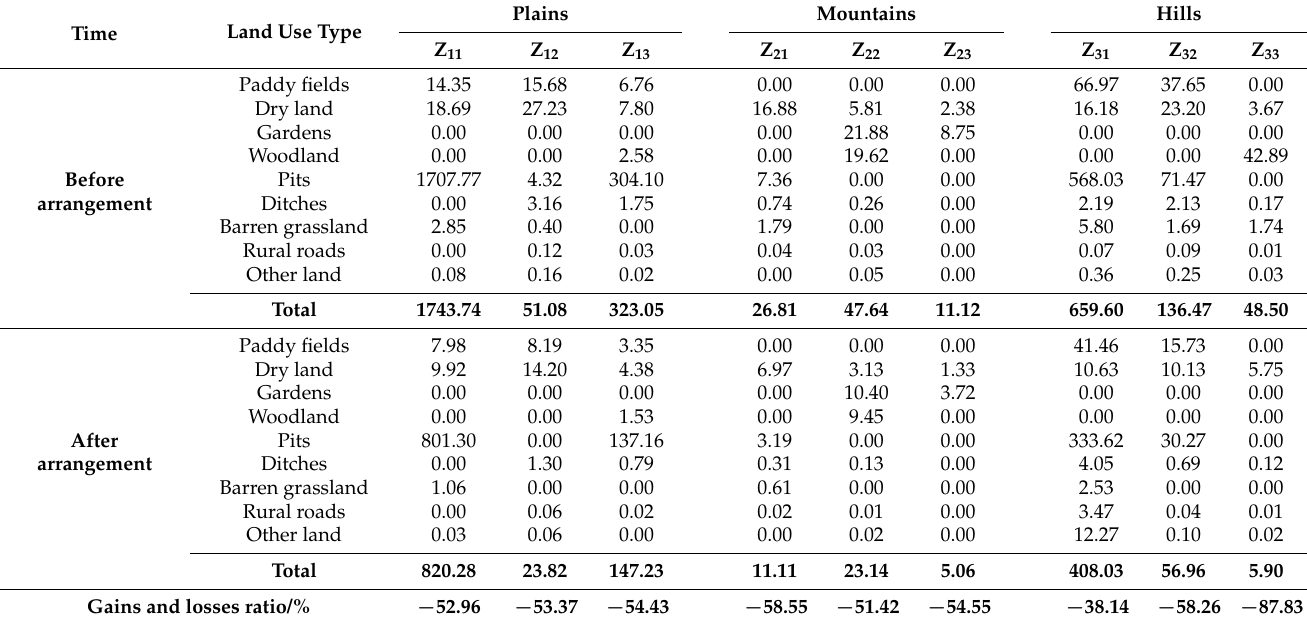
Table 5. Changes in the total amount of ESV before and after arrangement. Unit: × 10 5